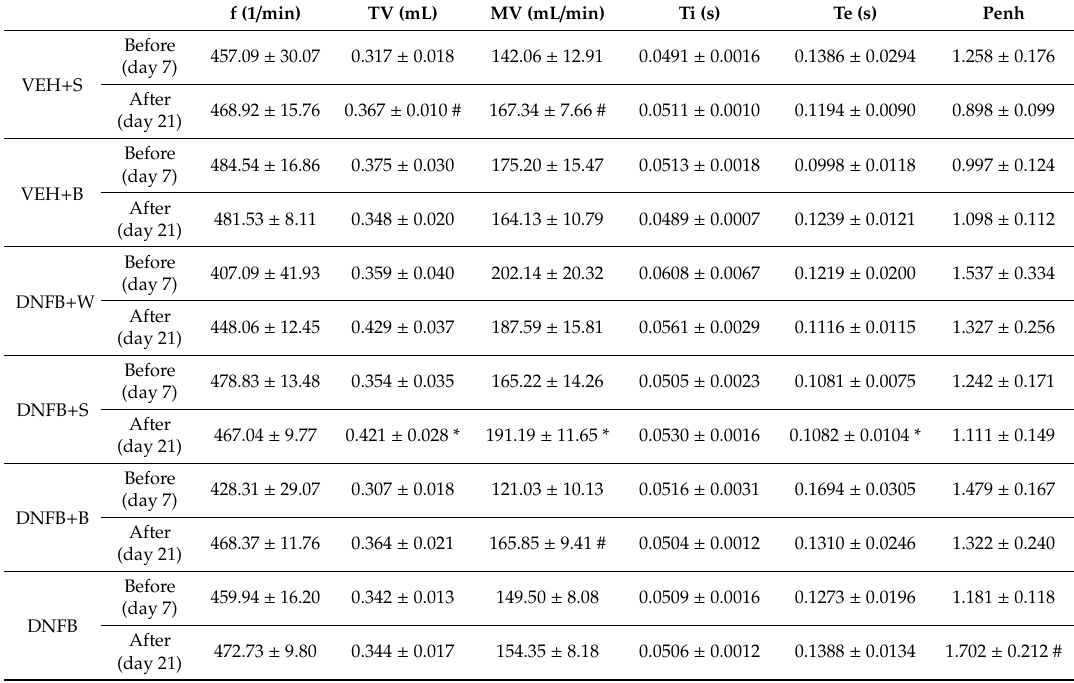
Table 1. Basal ventilatory parameters before (day 7) and after (day 21) inhalations (group sensitized but non-inhaled (DNFB) was not